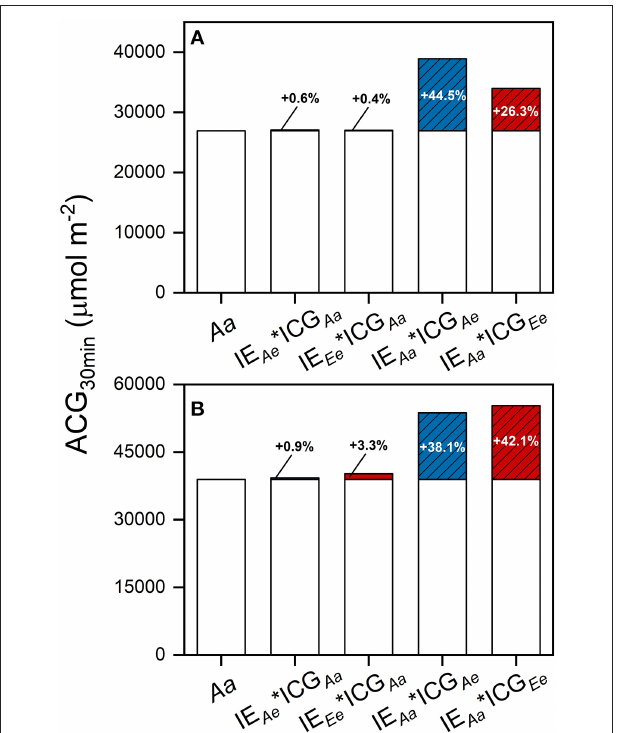
2 on ACG 30min by changes in photosynthetic induction and steady-state photosynthesis in rice (A) and wheat (B) leaves. The ACG under the Aa treatment was calculated by integrating P N over a time period of 30min following an increase in light intensity from 100 to 1,500 µ mol photons m − 2 s − 1 . Carbon gains under other hypothetical conditions were calculated by multiplying IE 30min and ICG 30min measured under different CO 2 treatments, as the subscripts indicate. IE 30min , IE over the first 30min of photosynthetic induction; ICG 30min , ideal ACG, calculated as the product of ( P N,1,500 – P N,100 ) and 30min. Values are means of three to four biological replicates, i.e., individual plants for each species. Blue bars indicate the substrate effect of eCO 2 and red bars indicate the sum of the substrate and acclimation effect of eCO 2 . Bars without any patterns indicate the effects of changes in photosynthetic induction and bars with oblique lines indicate the effects of changes in steady-state photosynthesis. Numbers indicate the percentage changes in ACG 30min , taking ACG 30min under the Aa treatment as the base